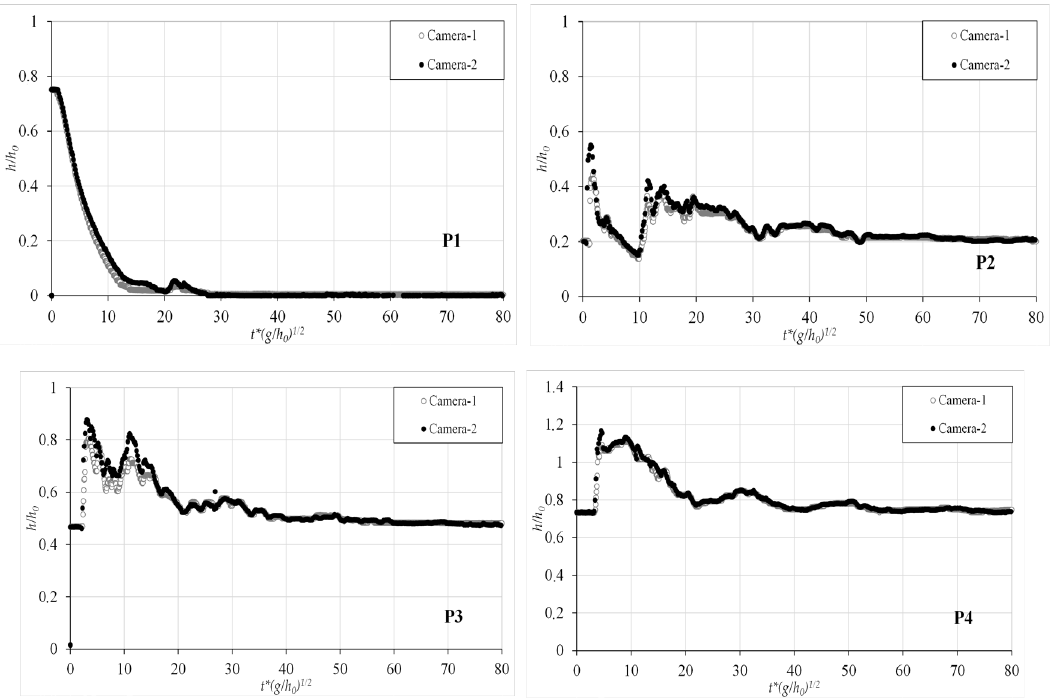
Figure 9. Comparison of the Camera Result.